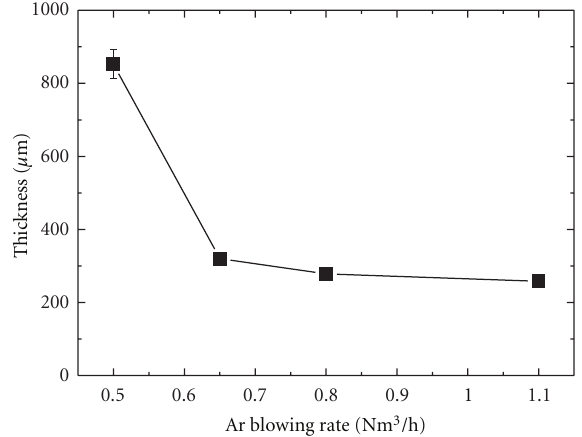
Figure 5: Thickness variation of ribbon-type Si wafers depending on the blowing rate of Ar gas at the range of 0.5–1.1 Nm 3 /h at the constant substrate temperature of 1000 ◦ C, time interval of 2.5 sec, and moving velocity of substrates of 485